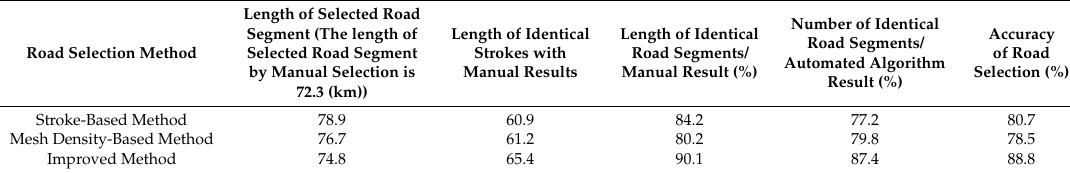
Figure 14. The results of road selection and deletion. Table 7. Statistical results for different road selection methods.